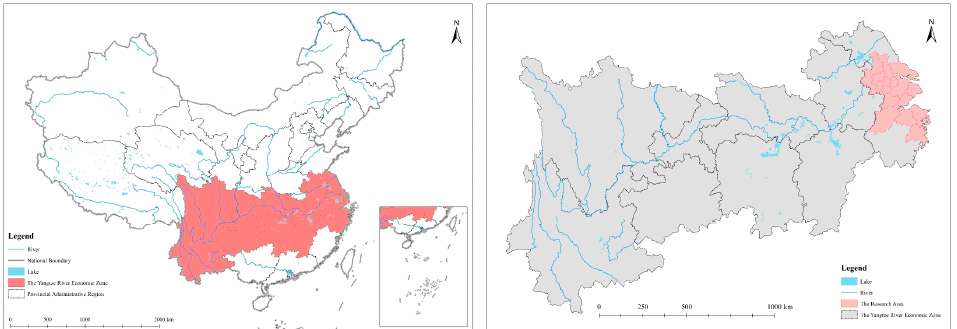
Figure 1. Location of the research area (The map on the left presents the relative position of the Yangtze River Economic Belt in China, while the map on the right presents the relative position of the Yangtze River Delta in the Yangtze River Economic